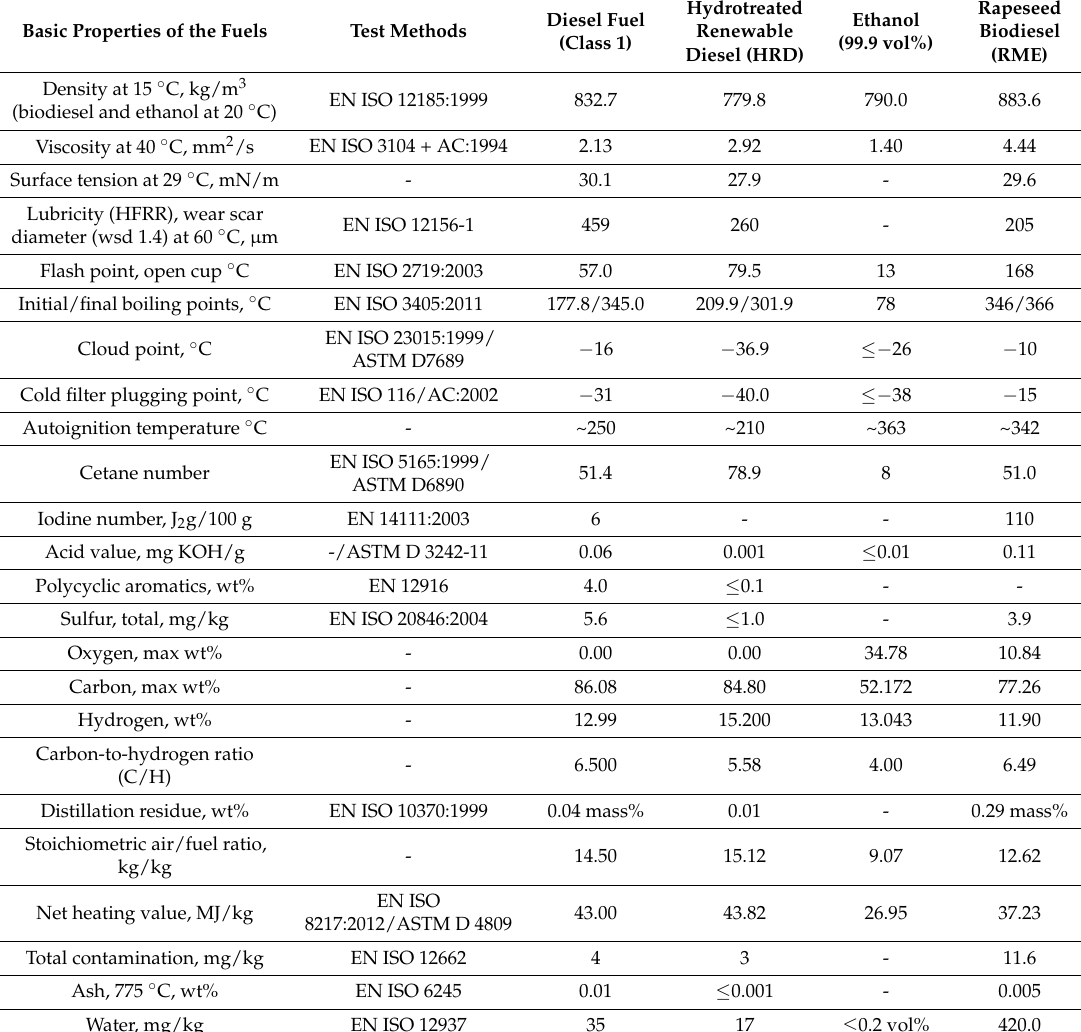
Table 3. Properties of commercial diesel fuel, renewable HRD fuel, ethanol, and rapeseed biodiesel